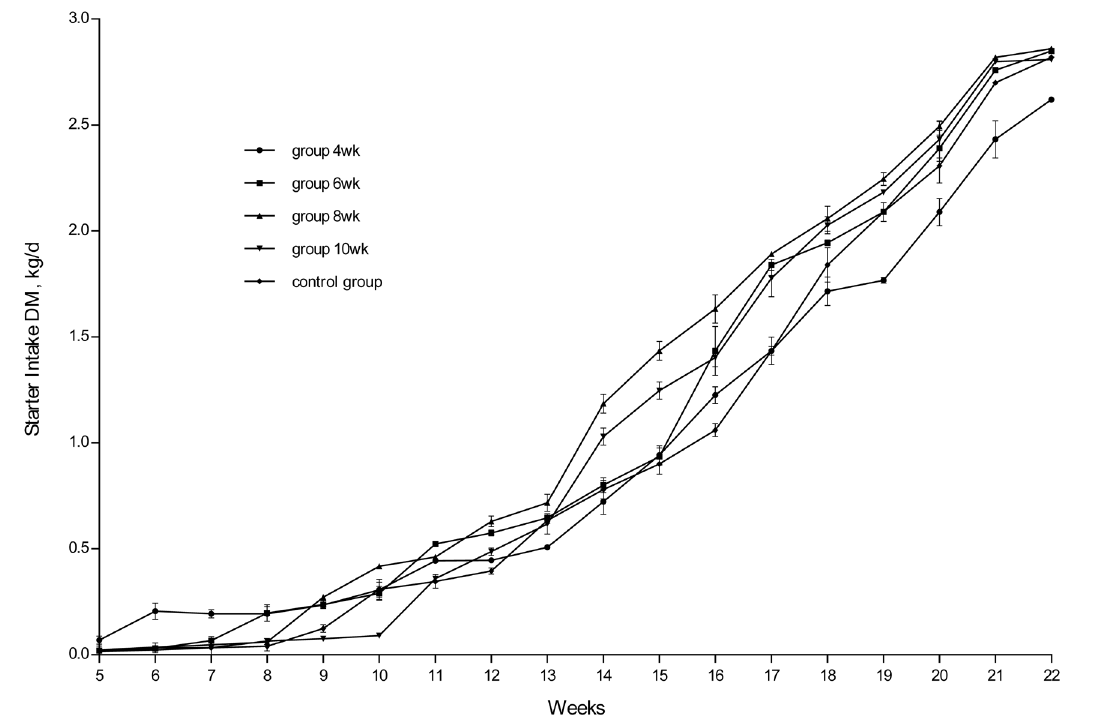
Figure 1. Effect of weaning age on starter intake of calves from 5 wk to 22 wk shown as means±standard